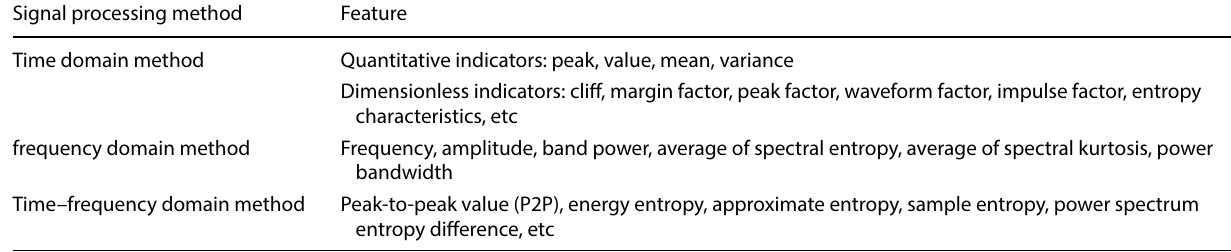
Table 2 Signal processing methods and characteristics Signal processing